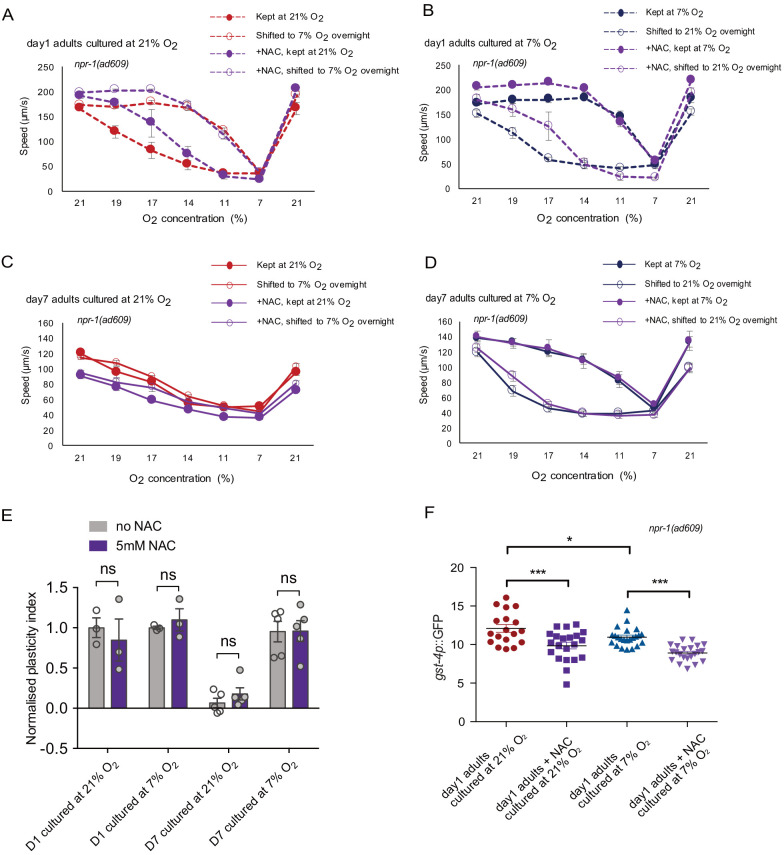
Organismal oxidative stress is not responsible for the accelerated plasticity decline with age for 21% O2 cultured animals.(A–D) O2-evoked speed responses of animals with and without 5 mM NAC treatment. Day 1 adults cultured at 21% O2 (A) and 7% O2 (B), and day 7 adults cultured at 21% O2 (C) and 7% O2 (D). Mean ±sem, three or more assays were performed for each condition. (E) 5 mM NAC treatment does not improve plasticity decline with age. Mean ±sem, ns, p>0.05, unpaired t-test. (F) Fluorescence quantification of gst-4p-induced GFP expression in animals with and without 5 mM NAC treatment. Mean ±sem, n = 13–23 animals each condition, *p<0.01, ***p<0.0001, ns, p>0.05, one-way ANOVA with Holm-Sidak test.